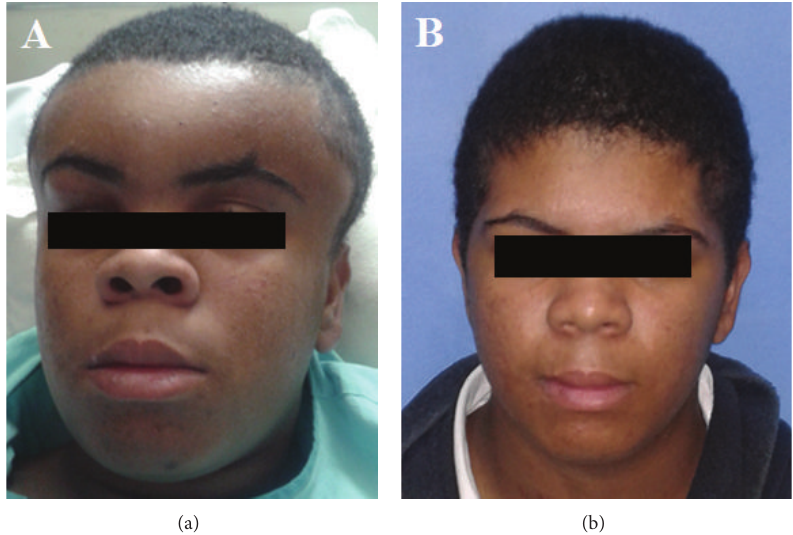
Figure 2: Preoperative image of the patient showing extensive forehead swelling (a), 40th postoperative day